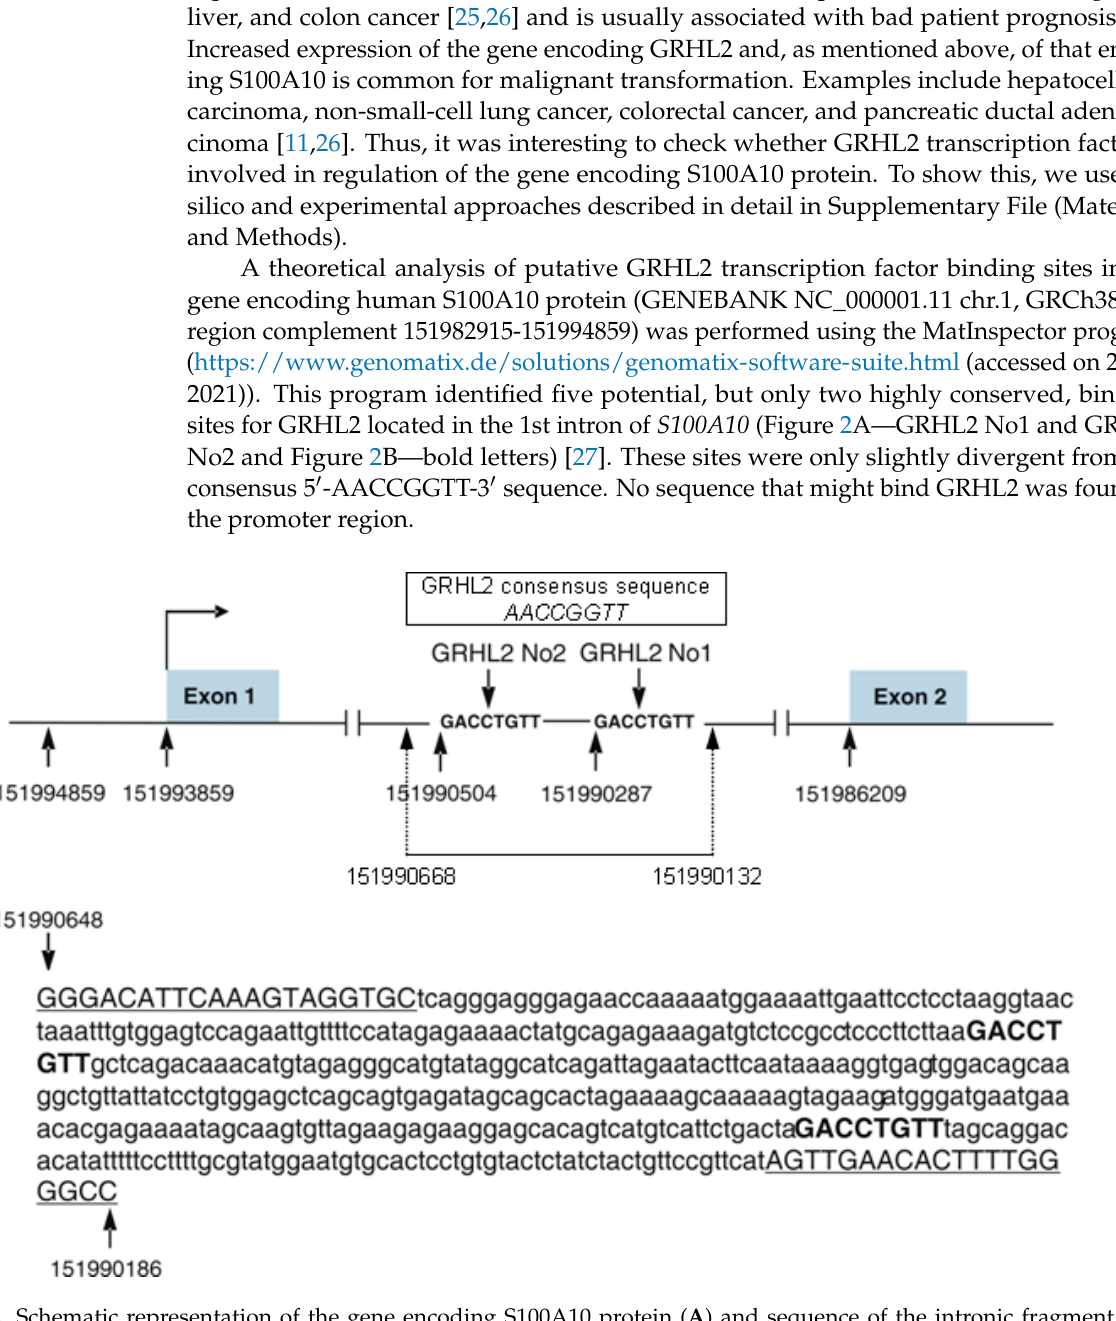
Figure 2. Schematic representation of the gene encoding S100A10 protein ( A ) and sequence of the intronic fragment amplified in ChIP ( B ). ( A ) Nucleotide sequence of two GRHL2 binding sites, GRHL2 No1 and GRHL2 No2. The 536 bp intronic fragment (151990668–151990132) cloned into pTA-Luc plasmid is indicated by dotted lines with arrowheads. ( B ) Nucleotide sequence of two GRHL2 binding sites (bold) and sequences covered by primers used for ChIP (underlined). Numbers are given according to GENEBANK NC_000001.11.